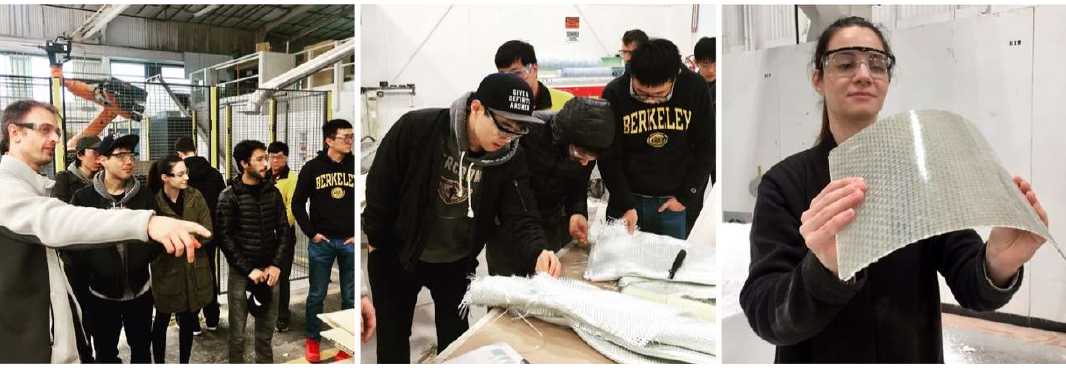
Figure 4. Students learn about composite manufacturing at the workshop of Kreysler & Associates.